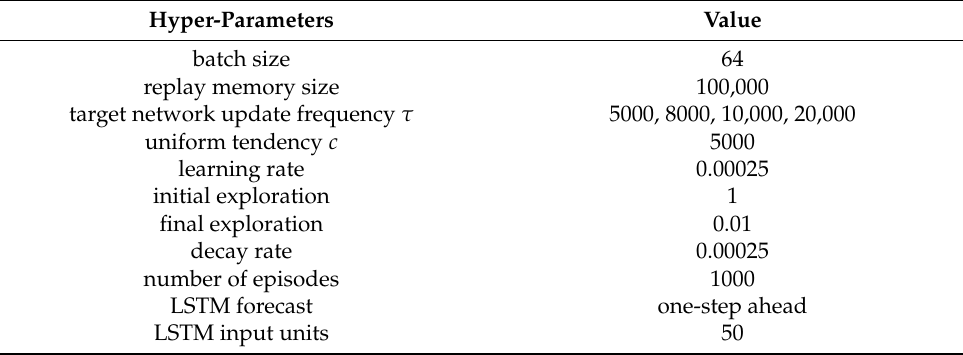
Table A1. The hyper-parameters used in CDQNrp and LSTM in real data